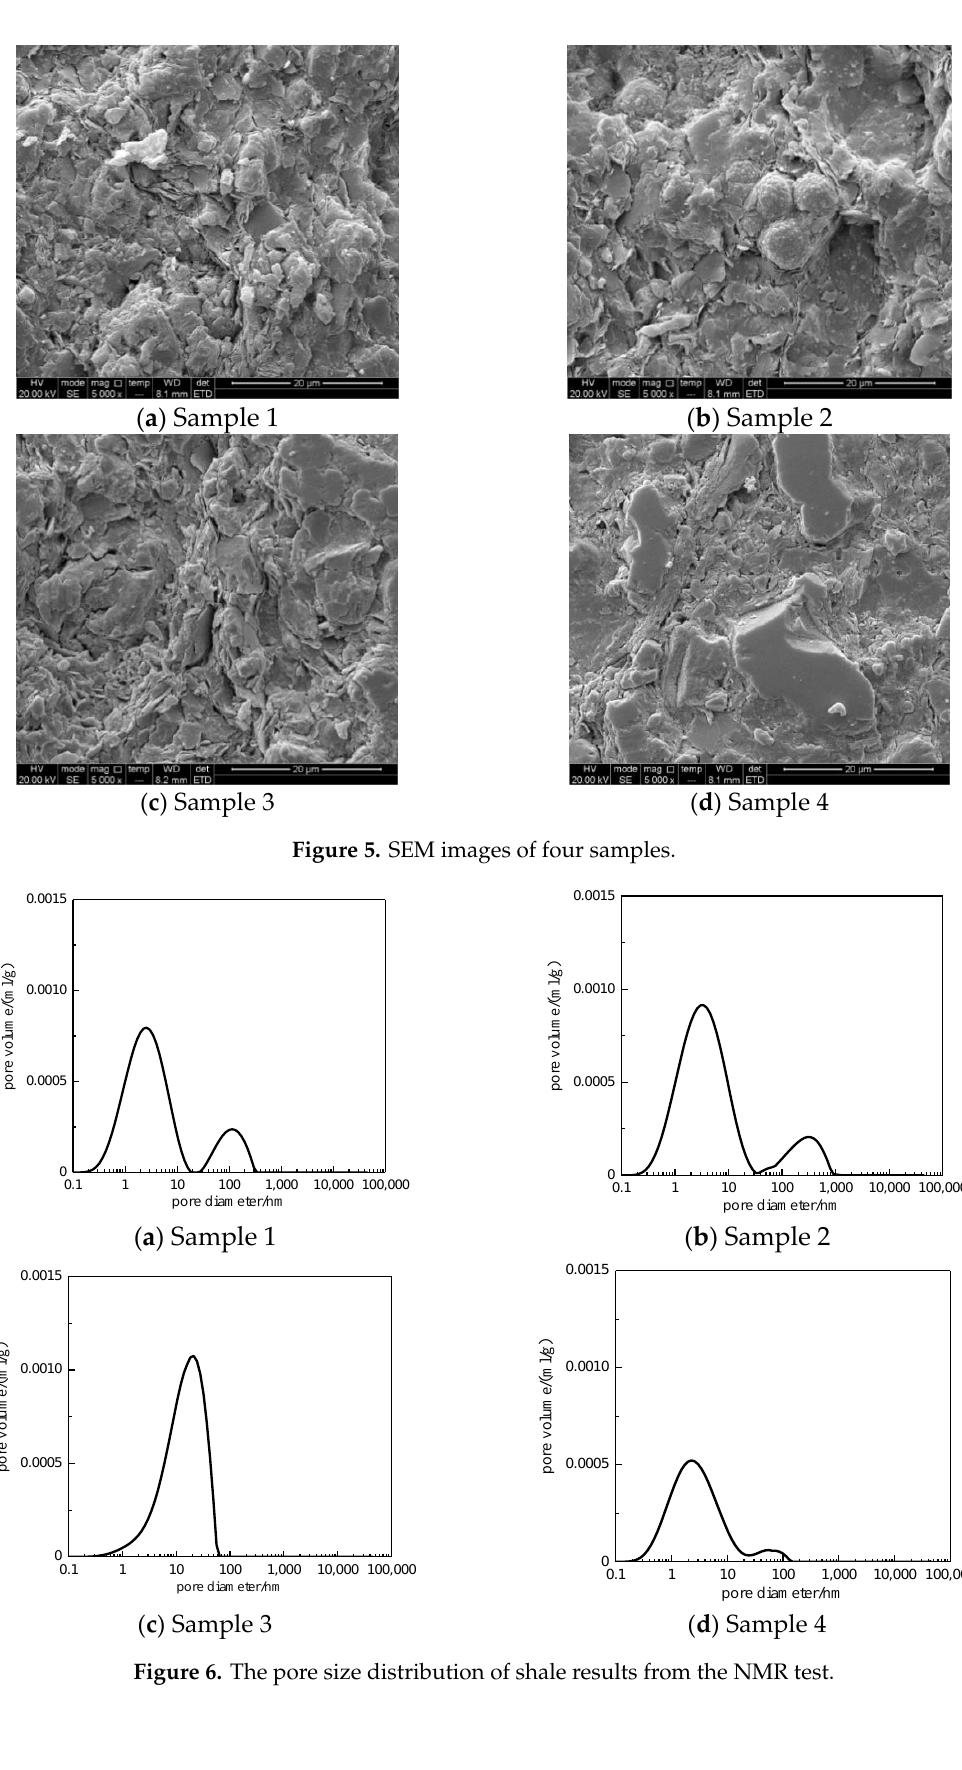
Figure 6. The pore size distribution of shale results from the NMR